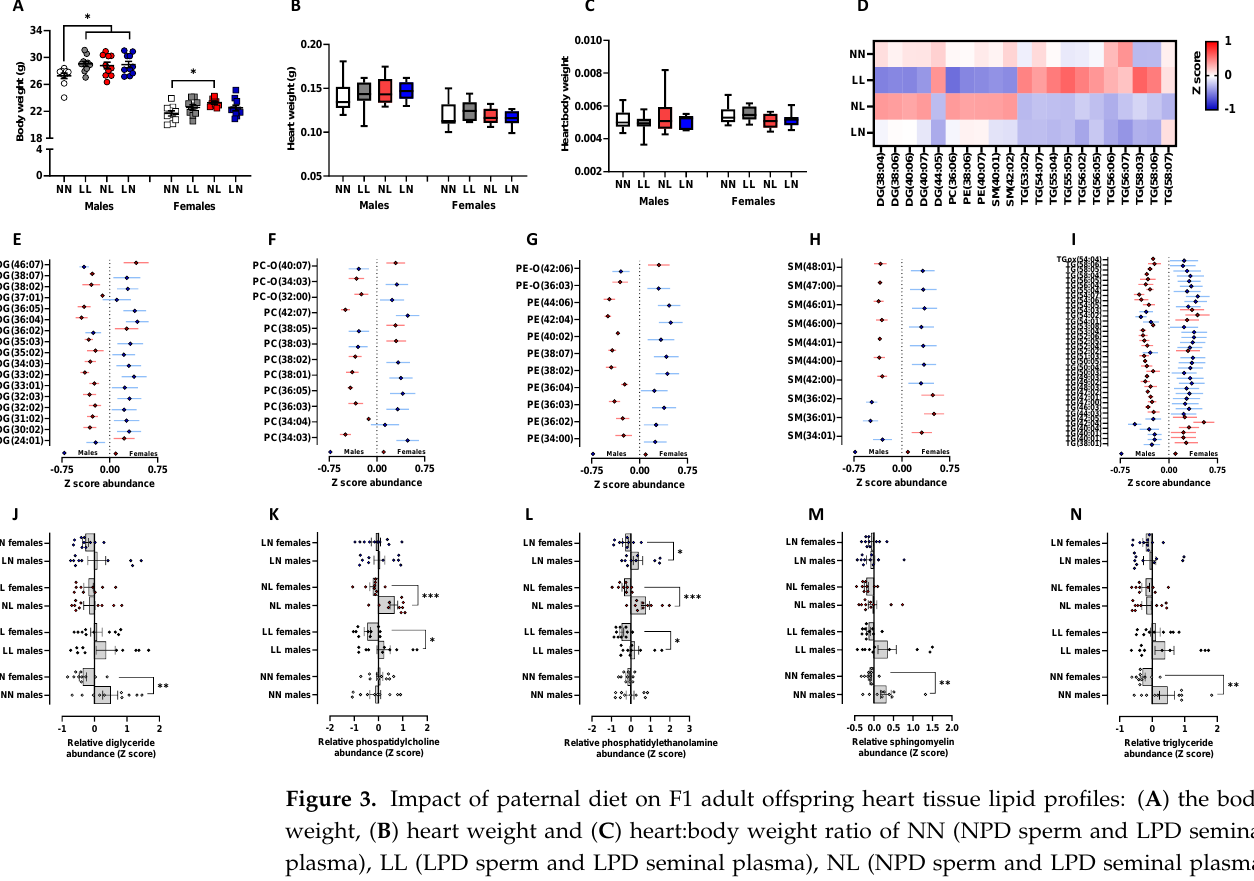
p < 0.05). Finally, in LN offspring, the serum abundance of cholesterol and sphingomyelins correlated positively to the maximal vasodilatory responses to acetylcholine (ACh Max), acetylcholine when in the presence of L-NAME (ACh L Max) and sodium nitroprusside (SNP Max) (Figure 4D; p < 0.05), while serum diglycerides correlated negatively to the maximal response to sodium nitroprusside (SNP Max) (Figure 4D; p = 0.035).